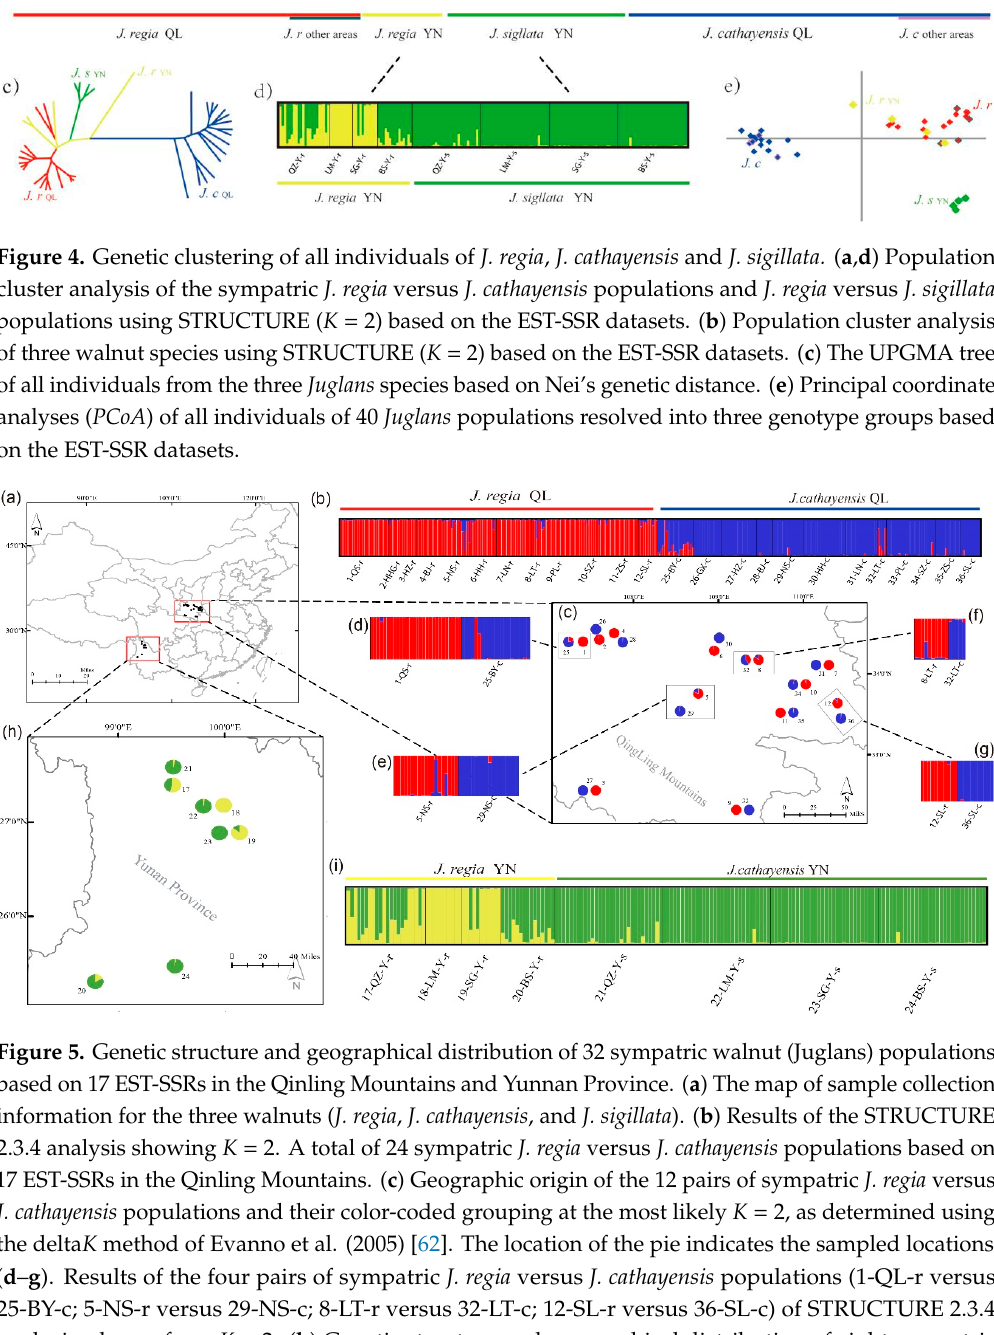
STRUCTURE 2.3.4 analysis showing K = 2. A total of 24 sympatric J. regia versus J.